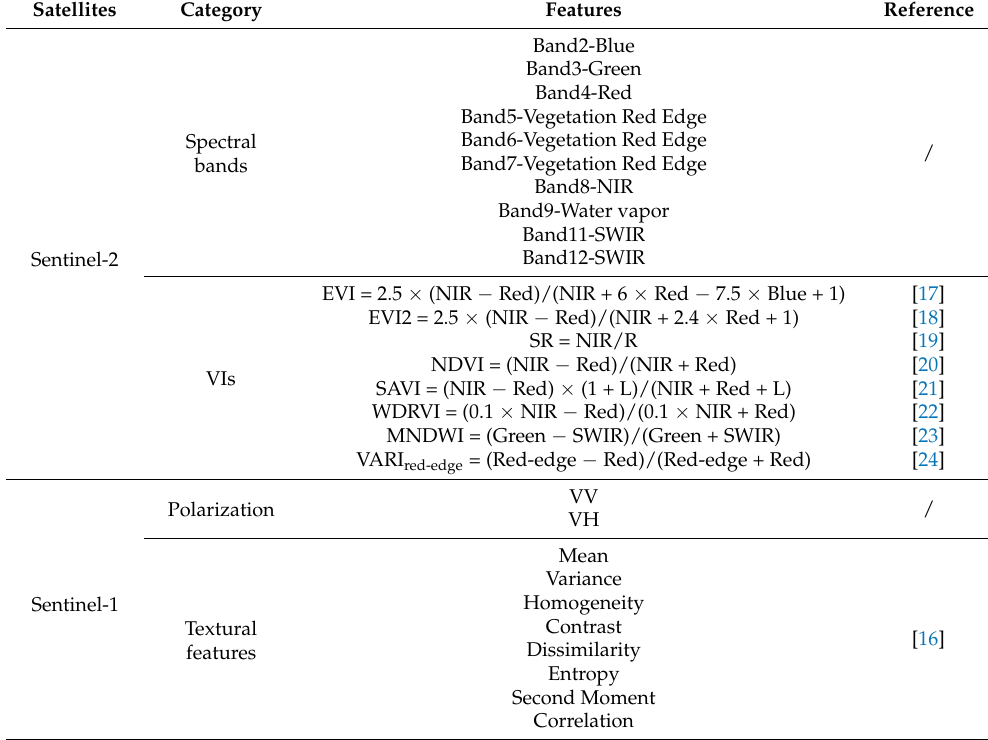
Table 2. Candidate optical and SAR features for rice